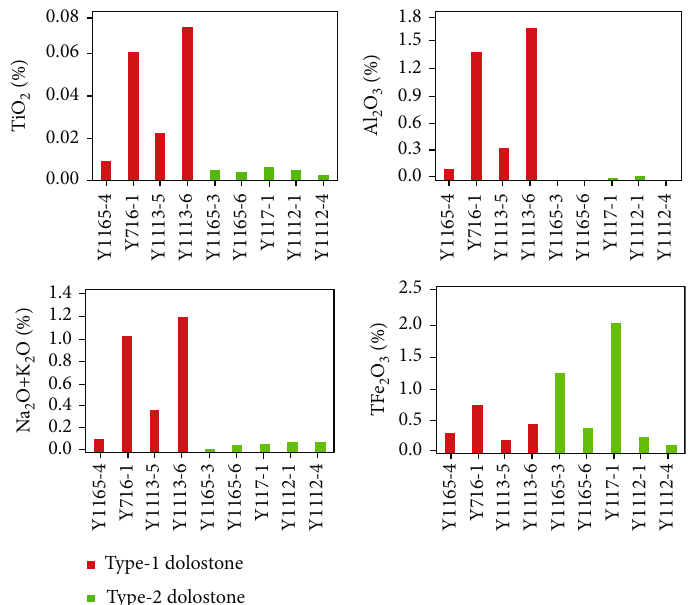
Figure 9: Histograms showing the distributions of the major and trace elements in the di ff erent type of dolostones from submember Ma5 of the Majiagou Formation in the northwestern Ordos Basin.